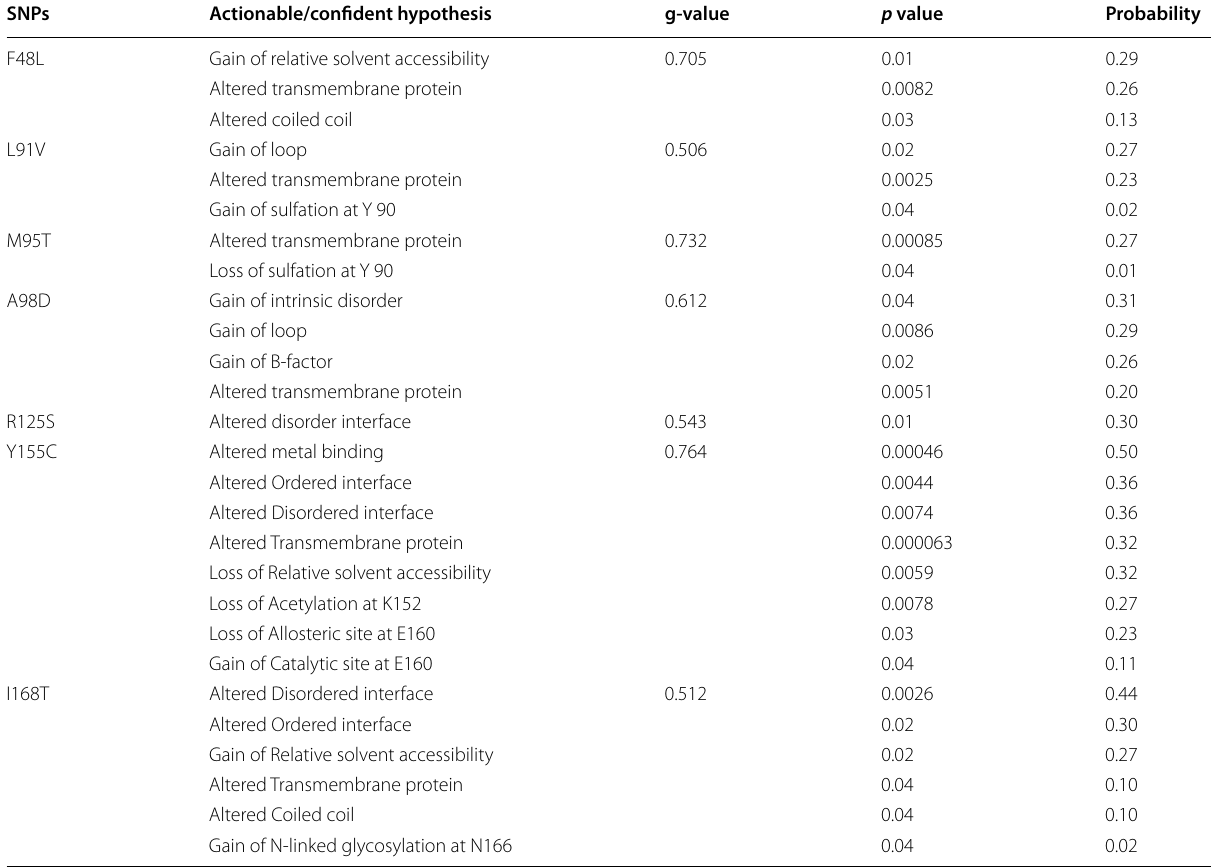
Table 2 Functional and structural modifications of IL-10 predicted by MutPred2. Here ‘g-value’ stands for general score of MutPred2 SNPs